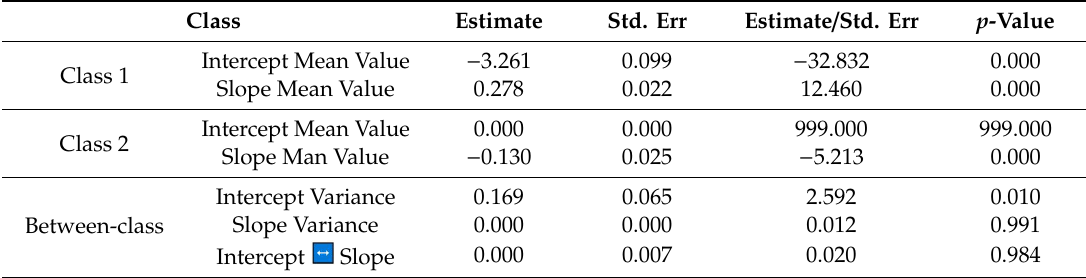
Table 7. GMM results of the Chinese elderly’s health